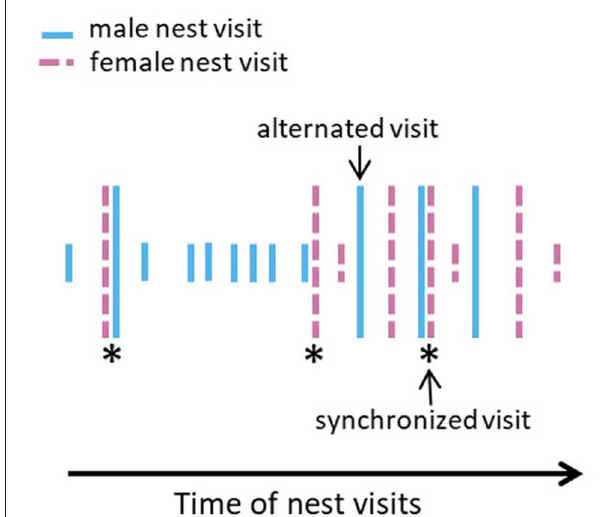
FIGURE 1 | Illustrative timeline of provisioning visits, with each bar representing a visit [female and male visits, in pink (dashed bar) and light blue (solid bar), respectively]. Longer bars represent alternated visits. Asterisks highlight synchronous